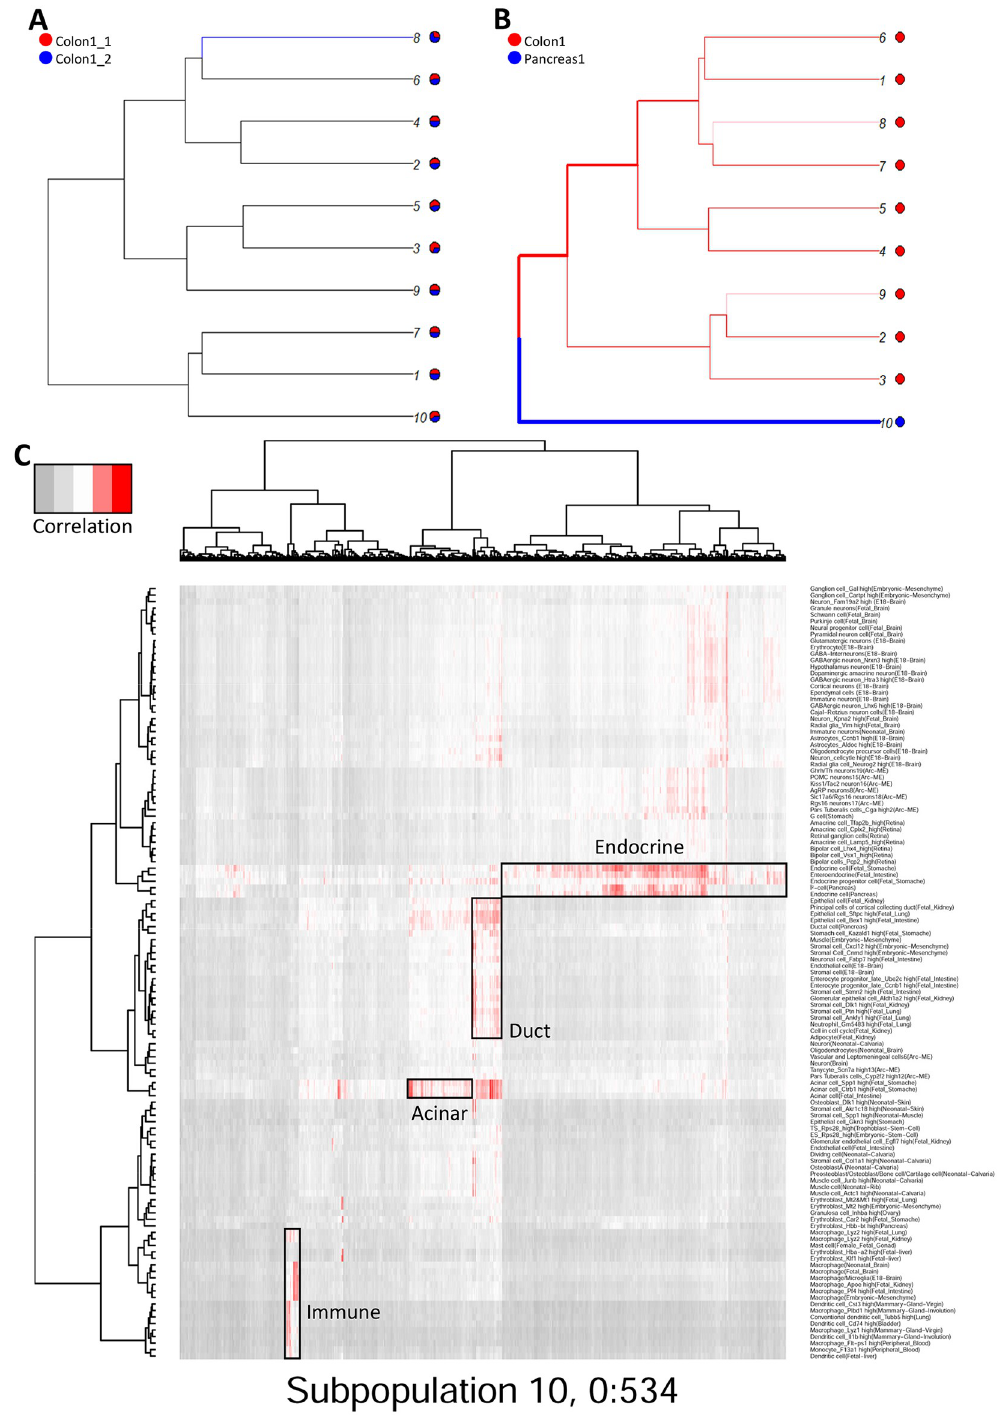
Fig 5. Cells that drive sc-UniFrac can be intuitively identified. (A, B) Branching structure of two single-cell landscapes being scored by sc-UniFrac (k = 10), with black representing statistically shared branches and blue and red representing statistically unshared branches from each of the colored samples. Thickness of branch is proportional to effect size. Comparing between (A) technical replicates and (B) different tissues. (C) Individual cells (columns) from group 10 of panel B being matched to cell types (rows) referenced from the Mouse Cell Atlas. Heat represents the correlation of gene expression between the cell and the reference using all genes. Data from GSE102698, GSE114044, GSE117616.